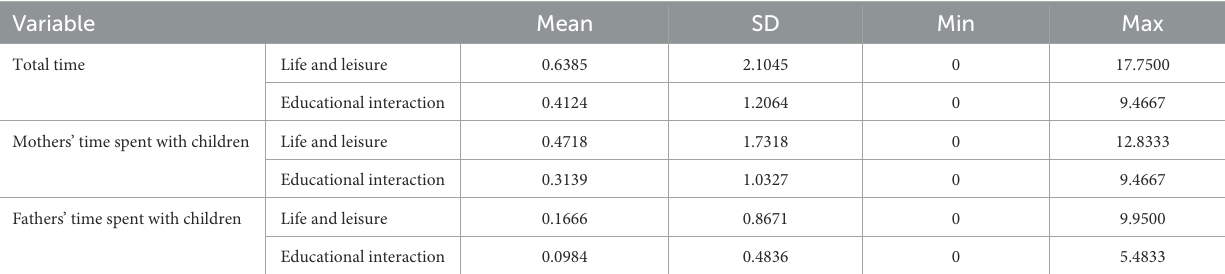
TABLE 5 Descriptive statistics for different types of time spend with children and different parental